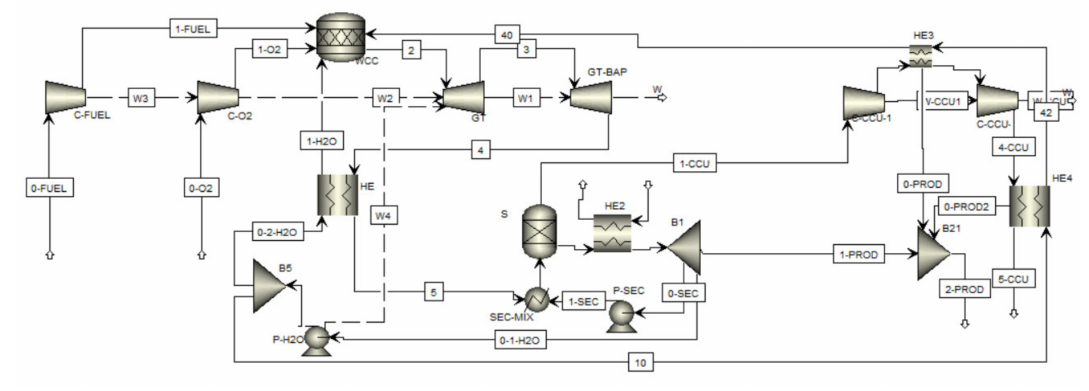
Figure 7. Simulation of PFD1 by Aspen HYSYS.